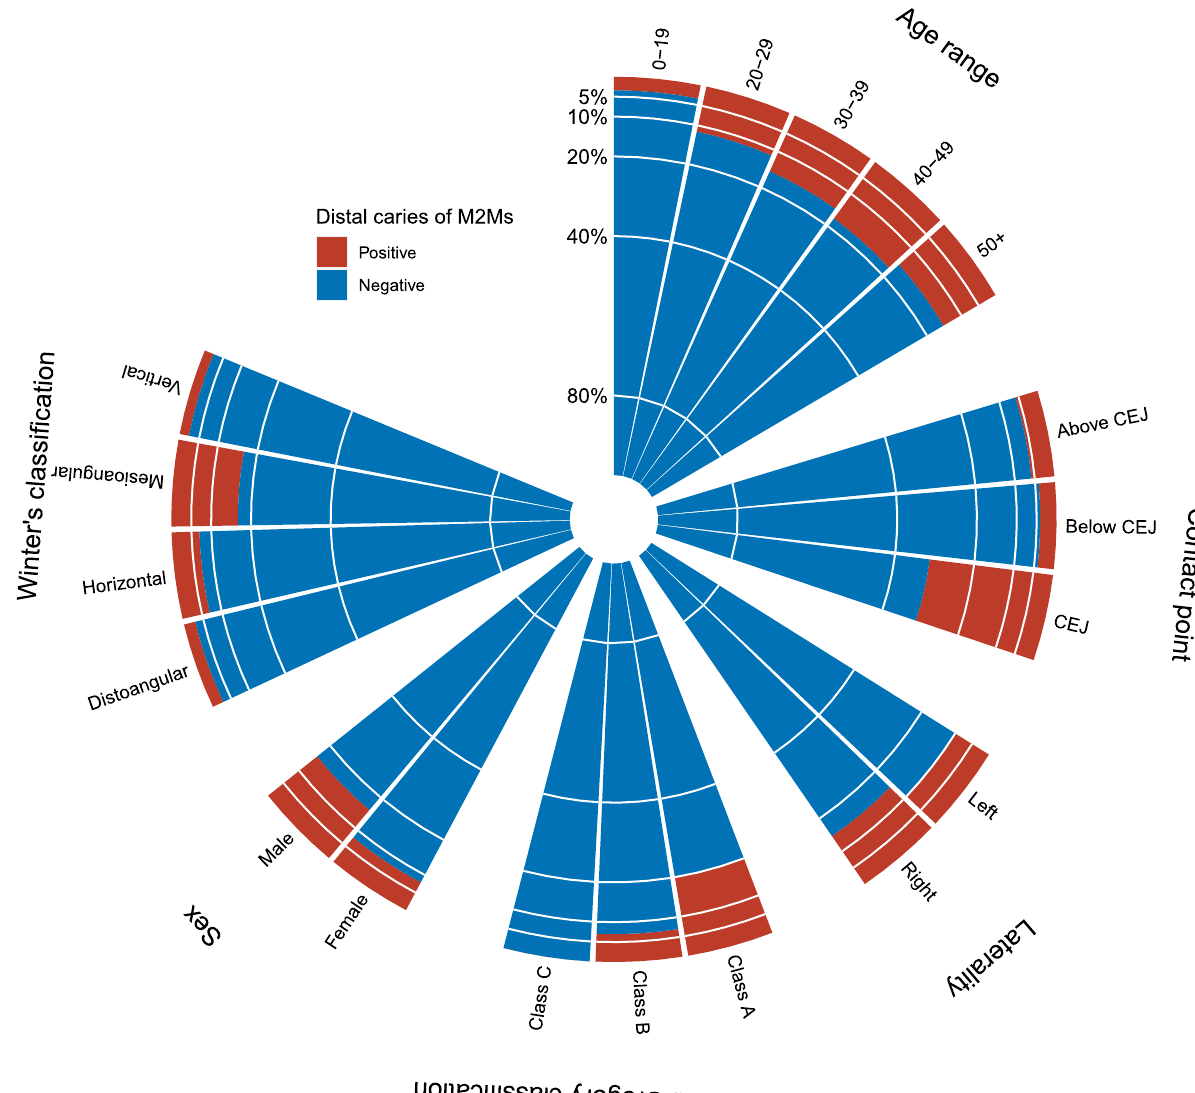
Figure 1. Polar histogram presenting the prevalence of DCM2Ms. DCM2M distal caries in mandibular second molars, M2Ms mandibular second molars, CEJ cementoenamel